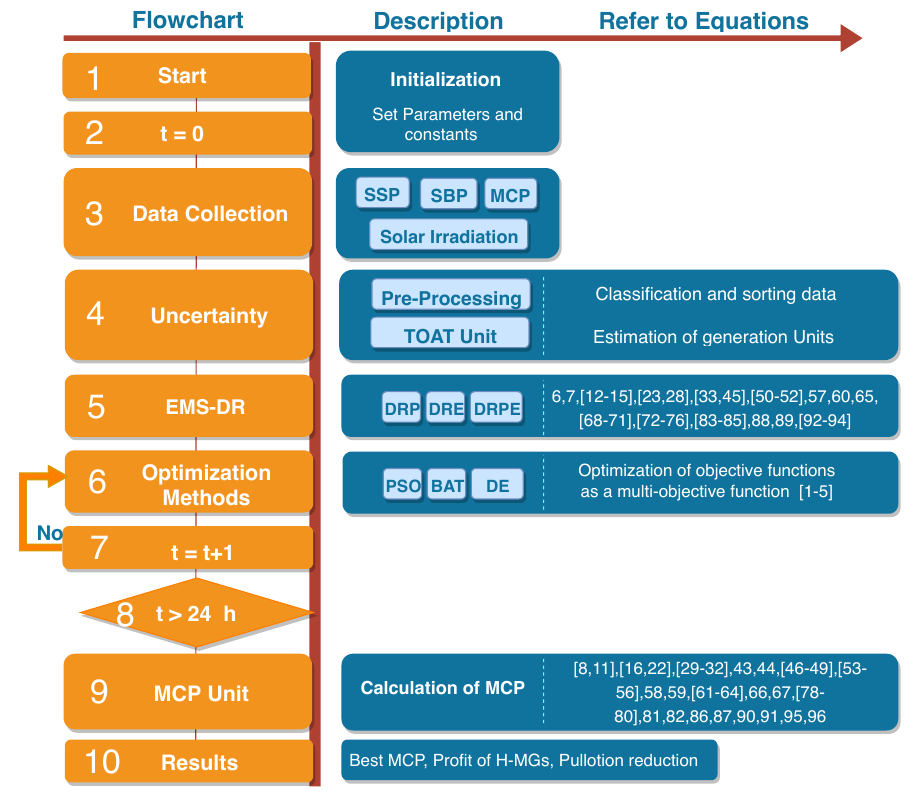
Figure 2. Flowchart of the proposed